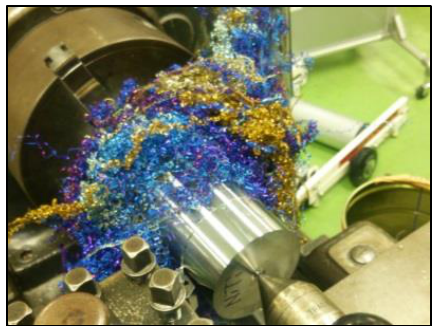
Figure 14. Tangling of chips with the jaw chuck and the cutting tool (v = 50 m/min, f = 0.1 mm/rev, t = 1.0 mm).